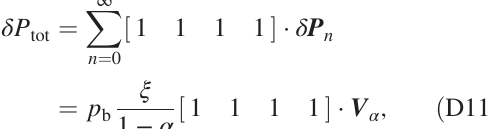
Fig. 13. We find weak in-phase synchronization, in particu- lar, the initial stages of growth, i.e., at low x .